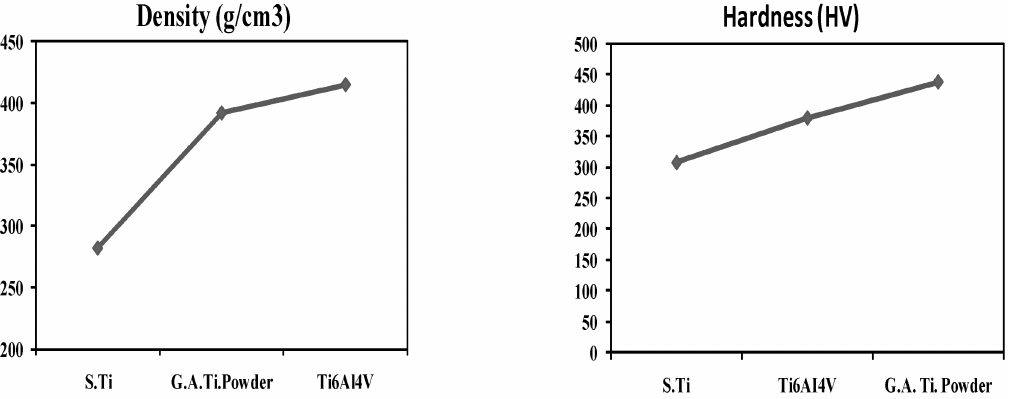
Figure 4. Results of the hardness and density measurements taken from the sintered sponge titanium, gas atomised tita- nium and Ti6Al4V